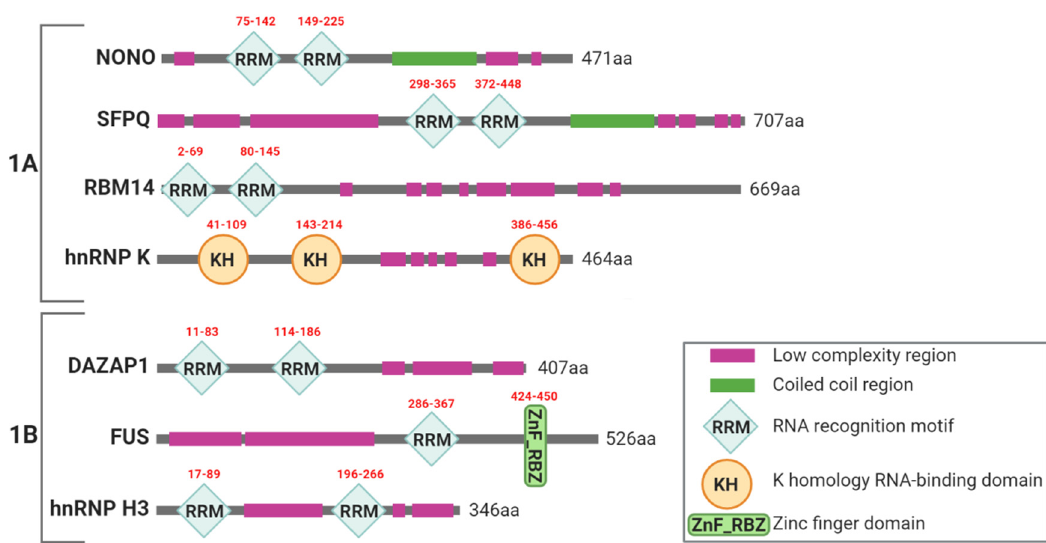
Figure 2. Schematic representation of essential PSPs belonging to category 1A and 1B and their major domains. The amino-acid length of each PSP is shown, whereas the amino-acid interval of each RNA-recognition motif (RRM), K homology RNA-binding (KH) and zinc-finger motif (ZnF) domain is indicated in red upon the corresponding region. Domain legend is shown in the box on the right.